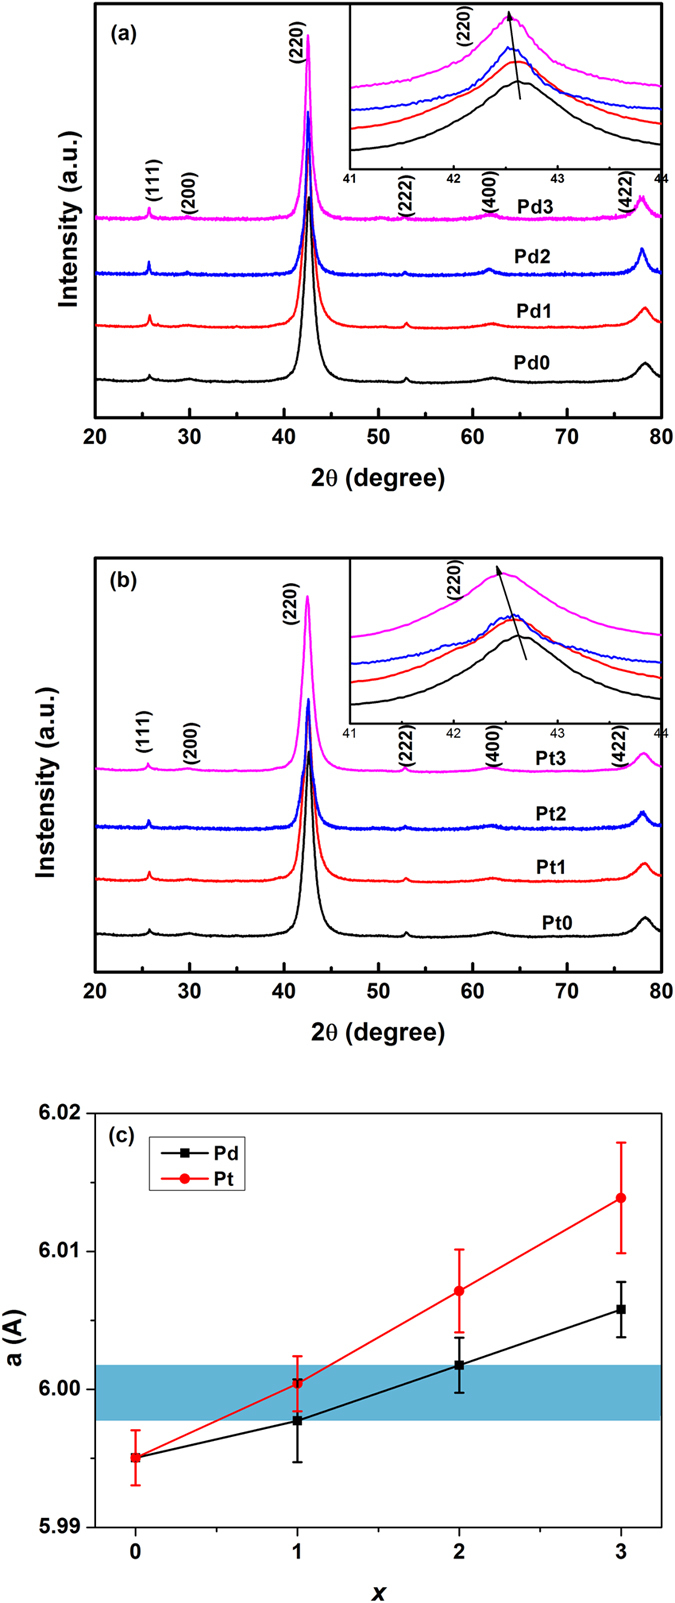
(a) The XRD patterns of Ni50−xMn36Sn14Pdx (x = 0, 1, 2, 3) alloys at room temperature; (b) The XRD patterns of Ni50−xMn36Sn14Ptx (x = 0, 1, 2, 3) alloys at room temperature; (c) The composition dependence of lattice constant. The blue region indicates the range of lattice constant where intermartensitic transformation appears.